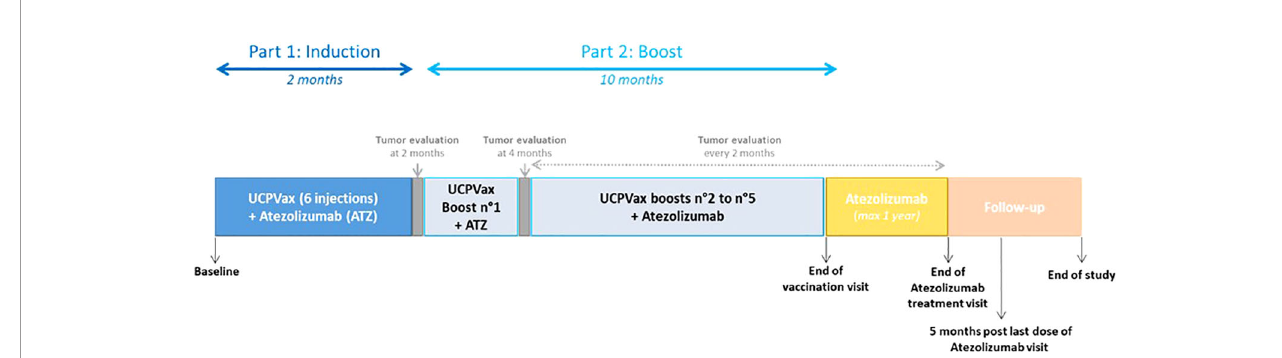
FIGURE 2 | Therapeutic sequences. Part 1 Induction phase: Atezolizumab (1,200 mg IV) will be administrated every 3 weeks starting at day 1. UCPVax will be injected subcutaneously at weeks 1, 2, 3, 5, 6, and 7. The two peptides included (UCP2 and UCP4) in UCPVax will be injected subcutaneously in separate sites (one site per peptide) after emulsion in the adjuvant (Montanide ISA-51 VG). Part 2 : Boost phase of UCPVax+. Atezolizumab: Atezolizumab will be administered at the standard dose of 1,200 mg IV every 3 weeks. UCPVax boosts vaccine will be performed every 6 weeks for the two fi rst boosts (W13 and W19) and then every 9 weeks thereafter (W28, W37, and W46). Part 3 : Atezolizumab in monotherapy will be administrated every 3 weeks until disease progression or unacceptable toxicities for a maximum of 1 year since the last